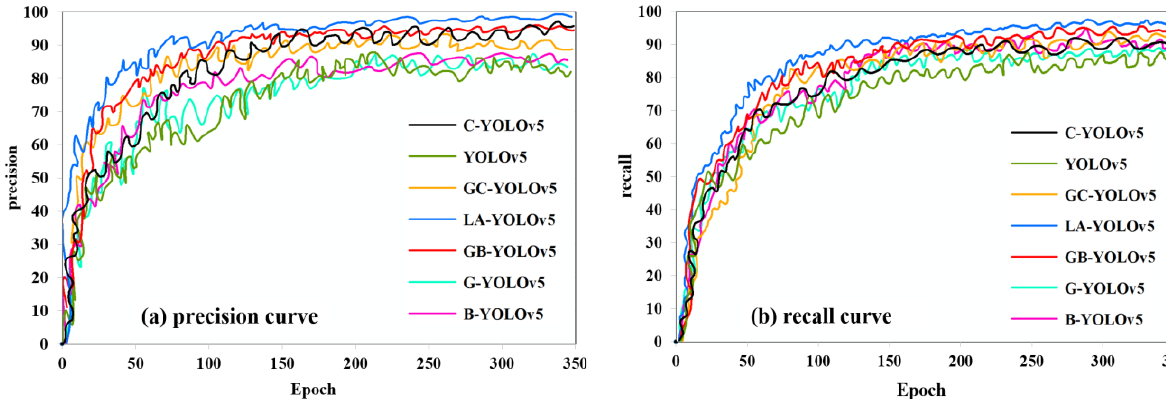
Figure 11. Evaluation comparison using different models.